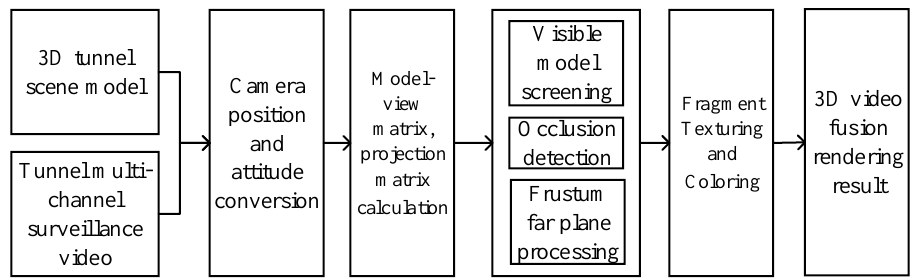
Figure 5. 3D real-time fusion method of tunnel multi-channel video.